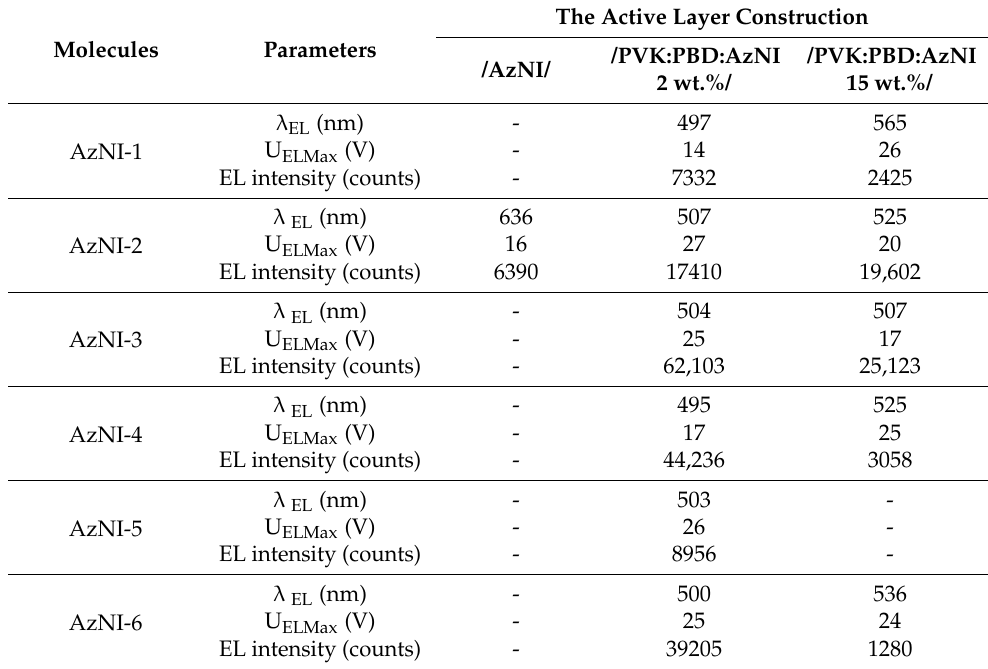
Figure 4. The ( a ) absorption, ( b ) excitation, and ( c ) 3D fluorescence spectra of AzNI–2 in chloroform solution by different concentration (c = 100, 80, 40, 20, 10, 1 μ M).